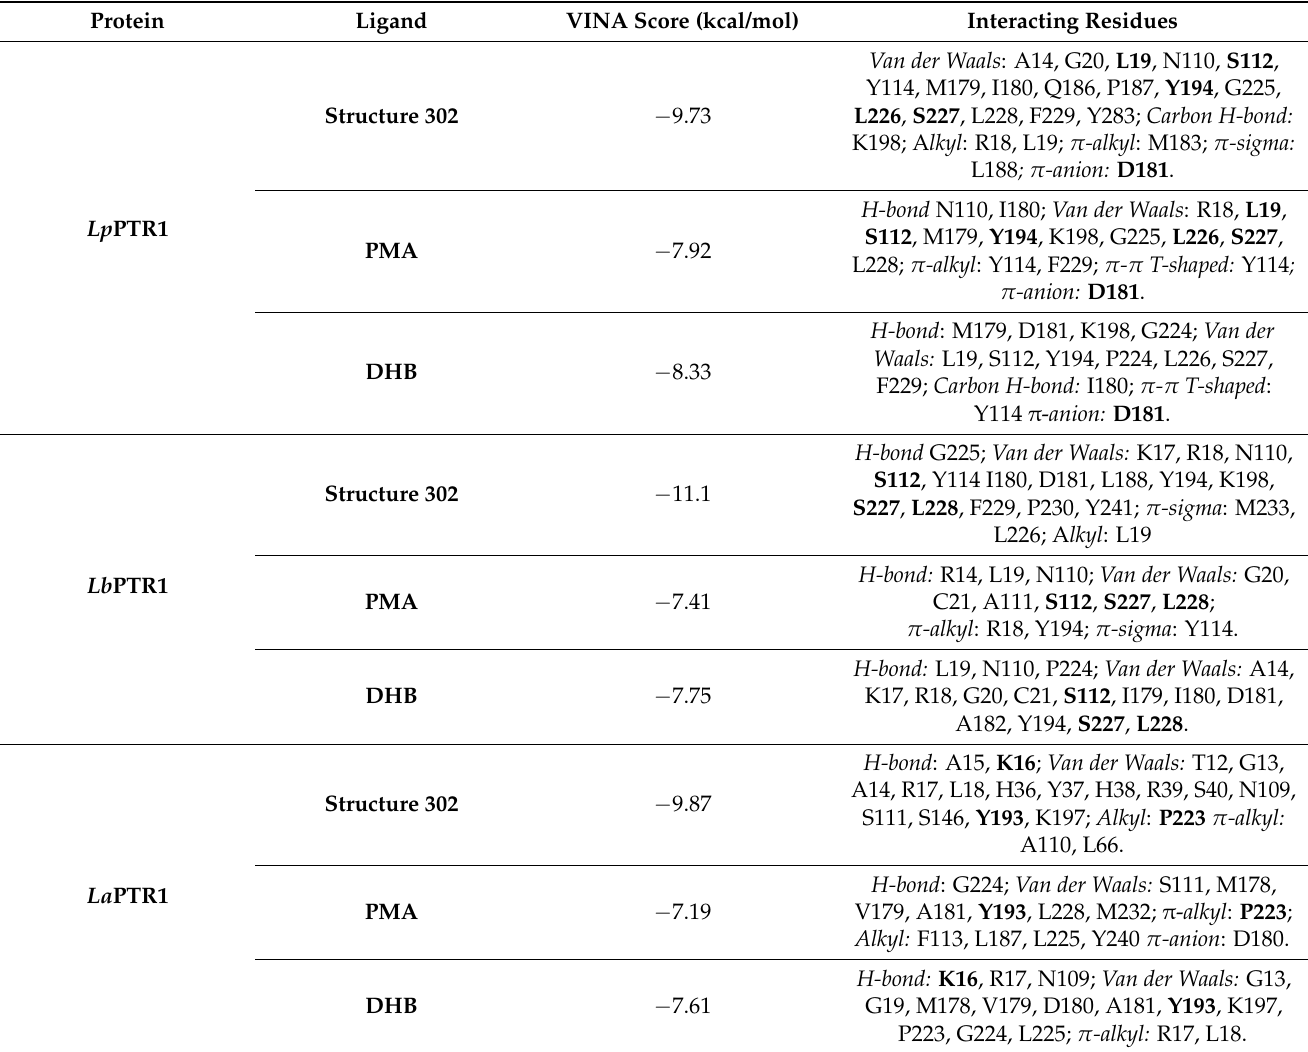
Table 5. VINA scores and interactions of structure 302 , PMA and DHB with amino acid residues of Lp PTR1, Lb PTR1, and La PTR1. Critical interactions are highlighted in bold